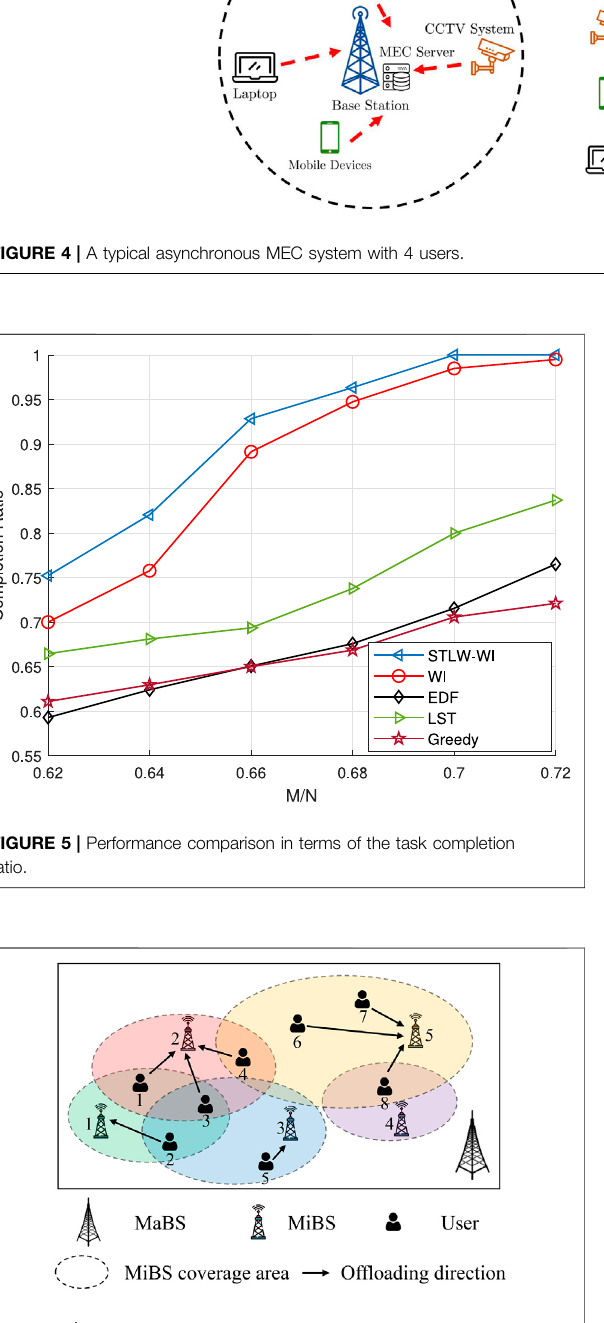
FIGURE 6 | An example of the system model with 5 MiBS and 8 users.